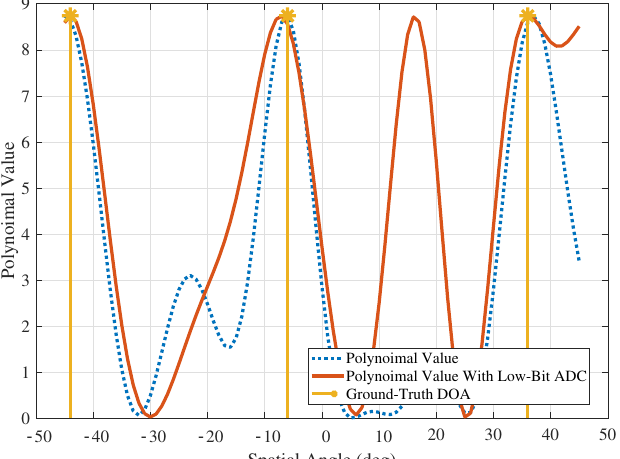
Figure 5. The DOA estimation results using the atomic norm minimization (ANM)